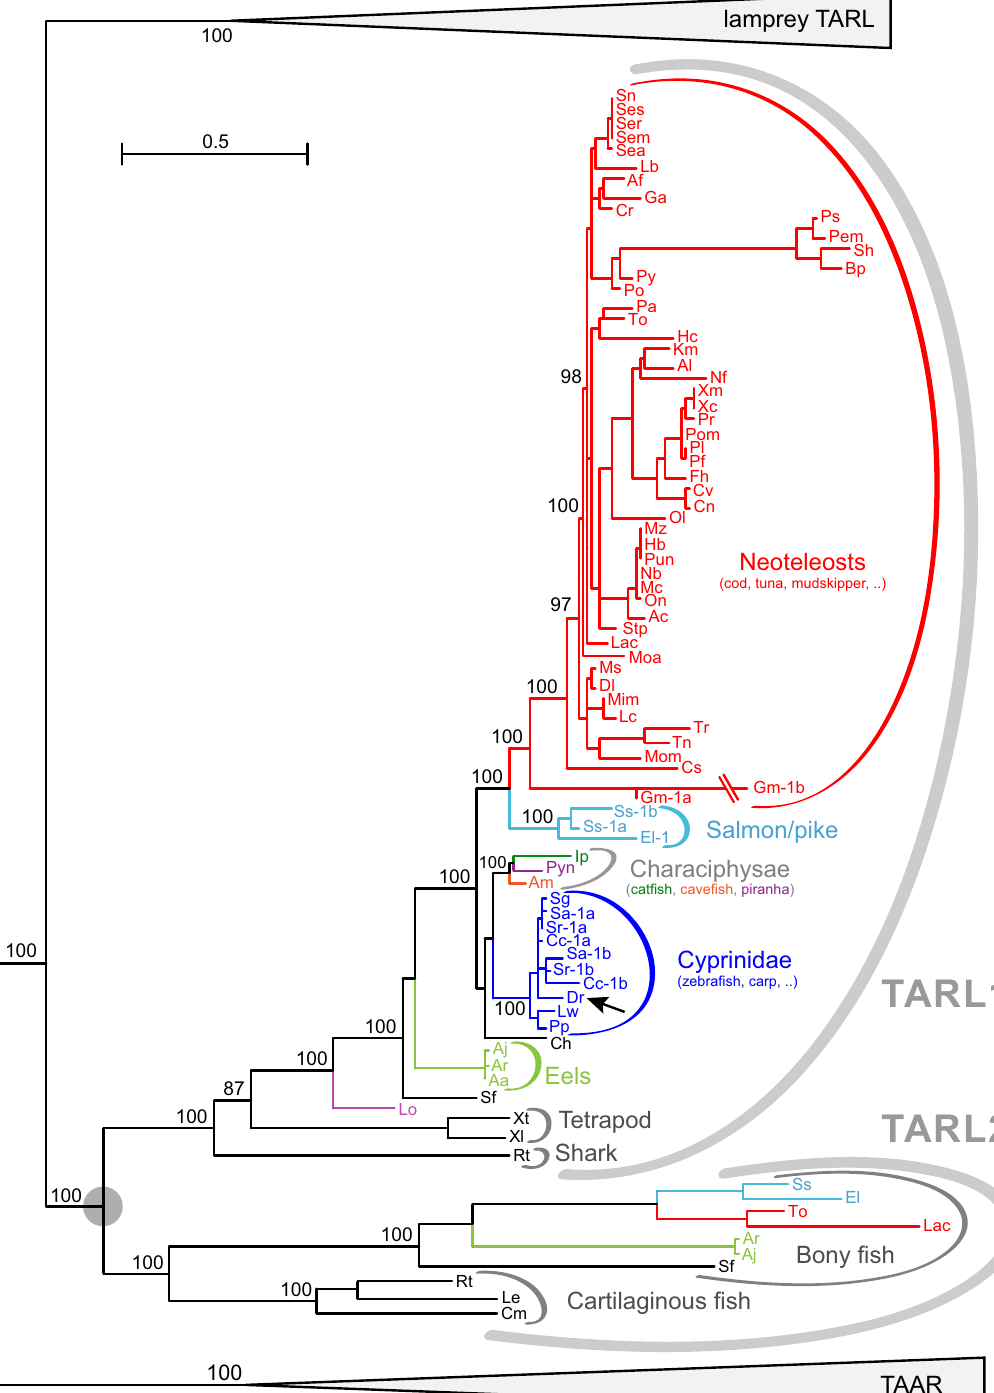
Figure 3. Phylogenetic tree of cartilaginous and bony fish taar -like genes. Phylogenetic tree of taar and taar - like genes, with all nodes collapsed (grey triangles) except bony and cartilaginous fish taar -like genes (ancestral node denoted by grey circle). Gene set and tree construction are same as in Fig. 1. Species are indicated by the initials of their Latin names, see Table 1 for full names, gene names as indicated. Note a basal duplication of the ancestral tarl gene into tarl1 and tarl2 clades. Late gene duplications are denoted by letters, e.g. Cc-1b stands for tarl1b of crucian carp. Note that this gene tree closely follows the corresponding species tree, with cartilaginous fish TARL occupying basal nodes, and TARL from earlier-derived bony fish (spotted gar, eel) basal in the bony fish TARL clade. Black arrow, zebrafish TARL1, whose expression is shown in Fig. 4. Without exception, neoteleost TARL are situated in the most-derived sub-clade (red). Numbers indicate % branch support for basal nodes (cutoff 80%). Scale bar, number of amino acid substitutions per